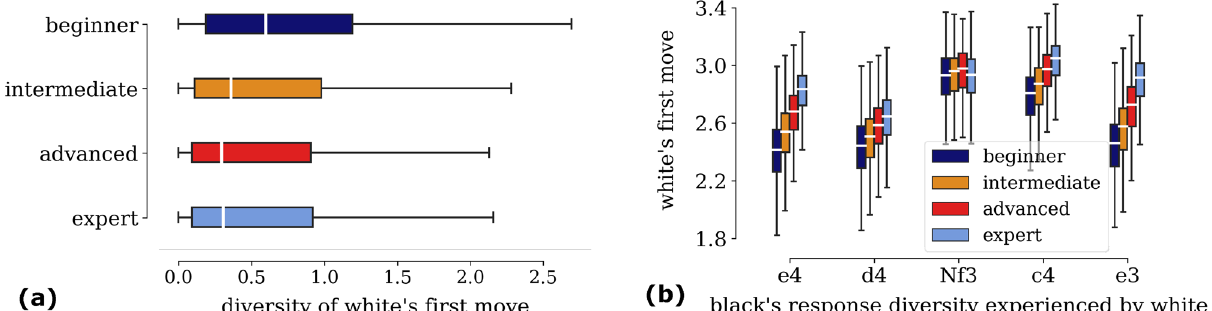
Figure 2. Diversity and specialization in the first move and black’s response. ( a ) Boxplots showing diversity (entropy) of first move by a player as white, calculated over all players individually and aggregated into the 4 different skill levels. Weak players start games with diverse collection of first move as white when compared to stronger players. ( b ) Boxplots showing diversity of black’s response experienced by white player, for each of white’s top 5 most played first moves— e 4, d 4, Nf 3, c 4 and e 3 (in descending order of popularity). As white, weakest players encounter lowest diversity in responses captured by low response entropy—for all of white’s most played opening moves, except